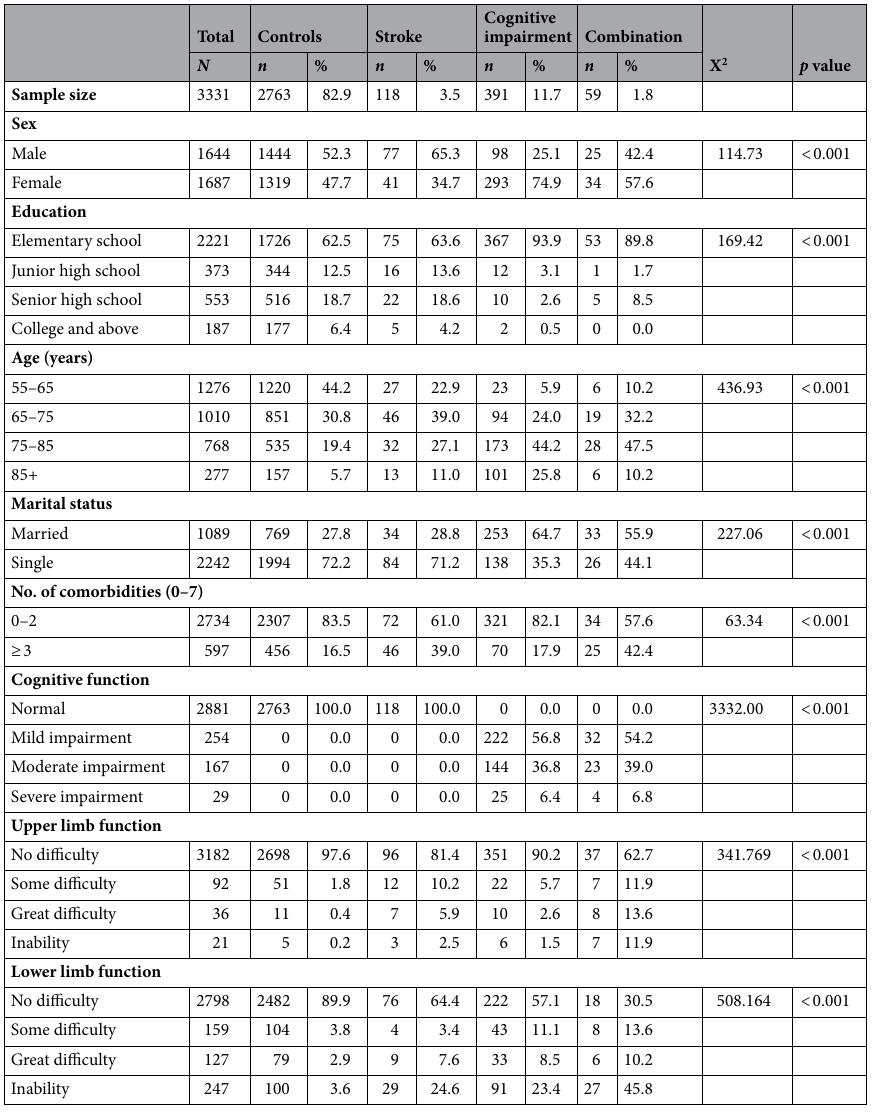
Table 1. Demographic data, comorbidities, cognitive and physical function of study